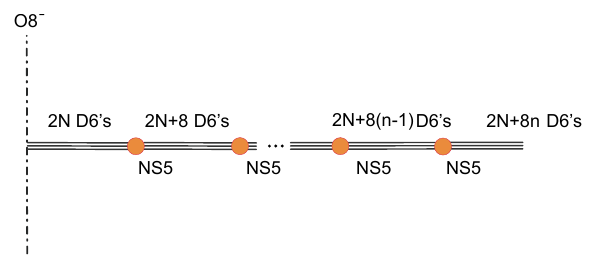
Figure 20 . Type IIA brane con(cid:12)guration for the 6d linear quiver theory (4.1).